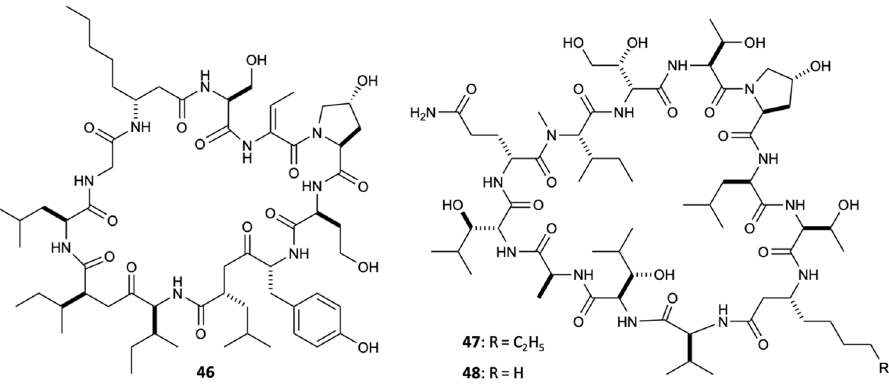
Figure 13. Structures of compounds 46 – 48 .